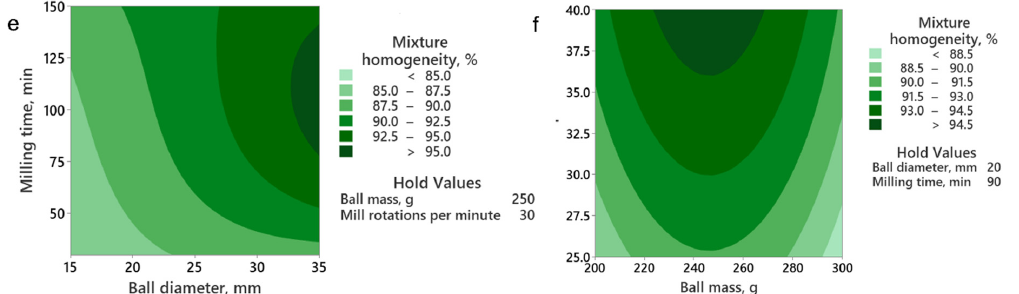
Figure 3. Interaction plots for the W + C mixture homogeneity after ball milling. Interaction plots represent the combined influence of mill rotations per minute and ball diameter ( a ), milling time and ball mass ( b ), ball mass and ball diameter ( c ), milling speed and milling duration ( d ), milling duration and ball diameter ( e ), and milling speed and ball mass ( f ).